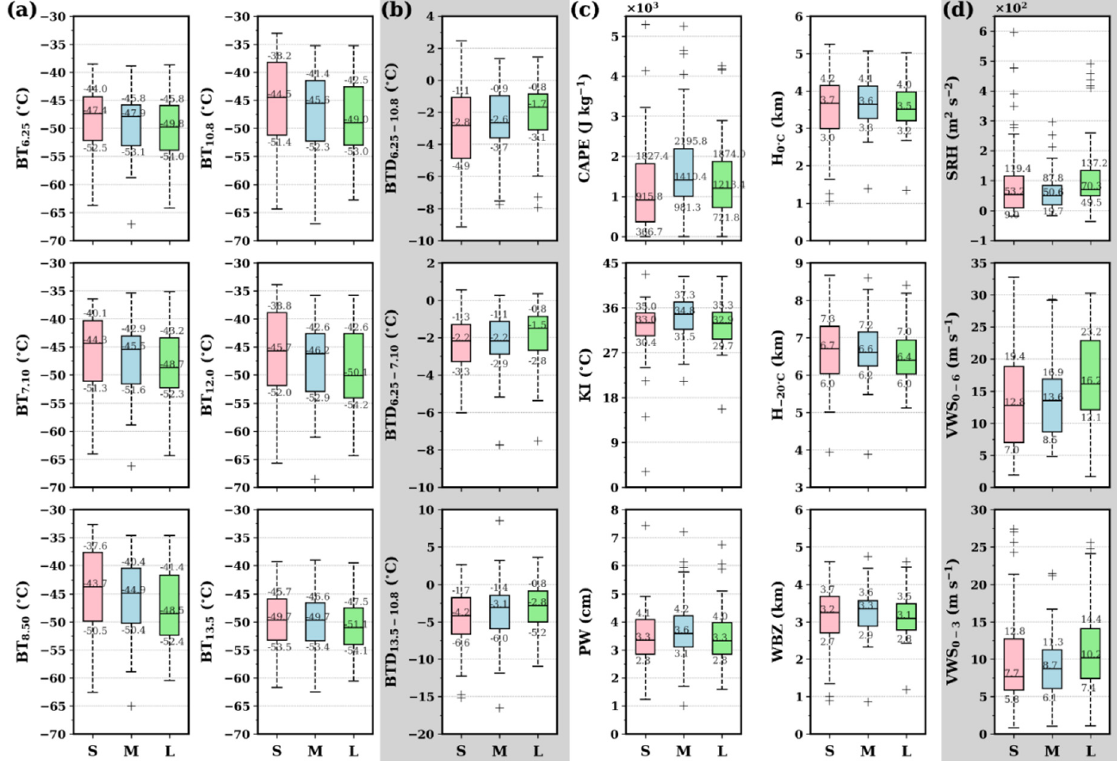
Figure 5. Box and whisker plots of the selected features for S- (red), M- (blue), and L- (green) size bins: ( a ) brightness temperature (BT), ( b ) the difference in BT (BTD), ( c ) thermodynamic, and ( d ) dynamic features. Each box’s bottom and top edge represent the 25th and 75th percentile, while the central line shows the median value (50th percentile). Plus signs mark the outliers whose values are more than 1.5 times the distance between the bottom and top edge. The upper (lower) whisker extends to the highest (lowest) datum without considering outliers. The digits in the bottom, middle, and top of each box denote the 25th, 50th, and 75th percentile values of the data set in each size bin, respectively.